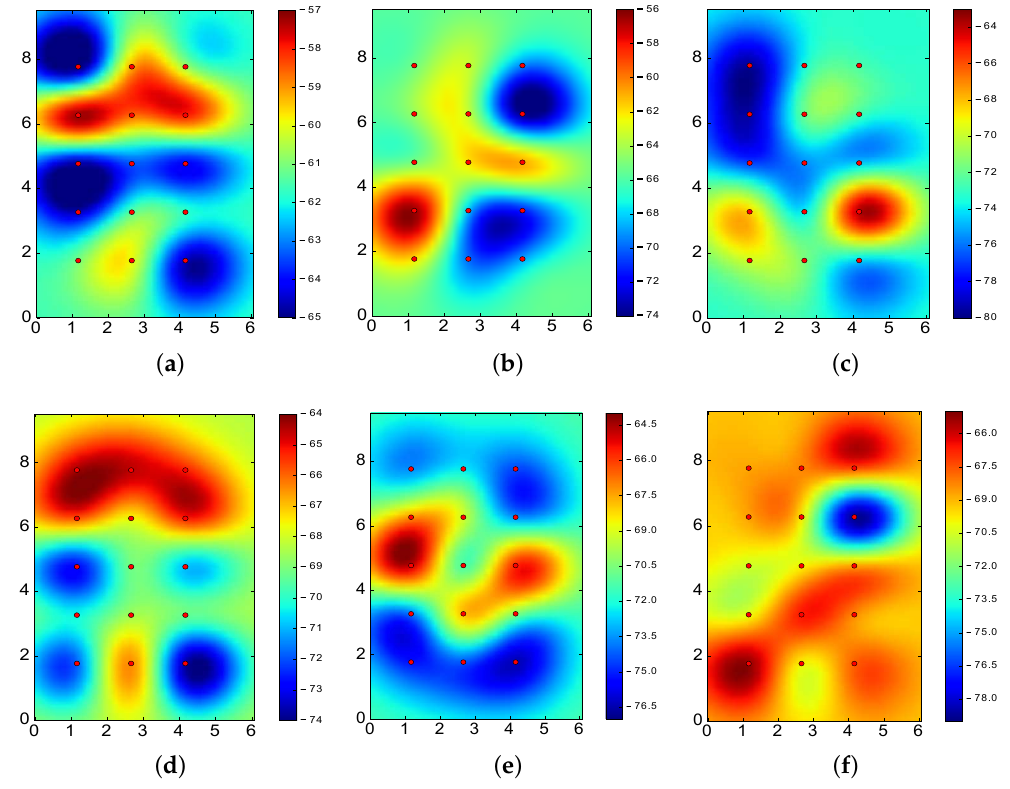
Figure 10. RSSI values for the best ( top ) and worst ( bottom ) transmission power ( Tx ) level for BLE4.0 beacons ’Be07’, ’Be09’ and ’Be10’ throughout the area captured by the BLE4.0 antenna. ( a ) Be07 with Tx = 0x03; ( b ) Be09 with Tx = 0x03; ( c ) Be10 with Tx = 0x03; ( d ) Be07 with Tx = 0x05; ( e ) Be09 with Tx = 0x05; ( f ) Be10 with Tx =